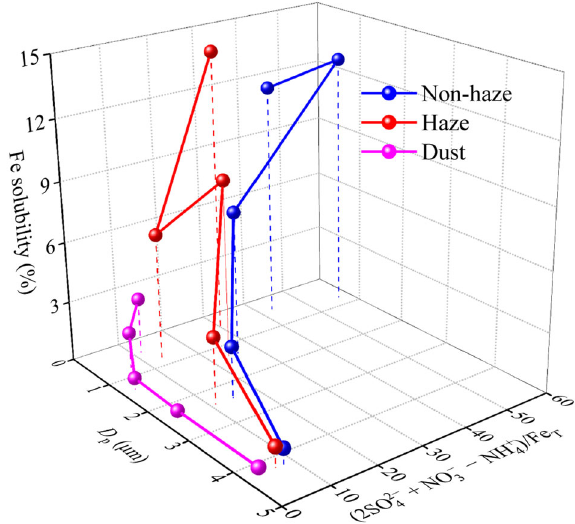
Fig. 4 Relationships between Fe solubility and the degree of aerosol acidi fi cation, as well as particle size ( D p ) in the size range of 0.32 – 5.6 μ m. The degree of aerosol acidi fi cation is indicated by the molar ratio of (2SO 42 − + NO 3 − − NH 4 + )/Fe T